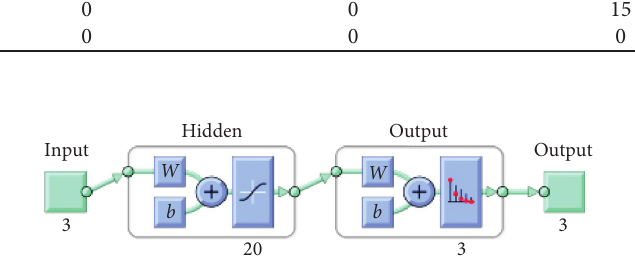
Figure 16: ANN model for sensor damage degrees identification.